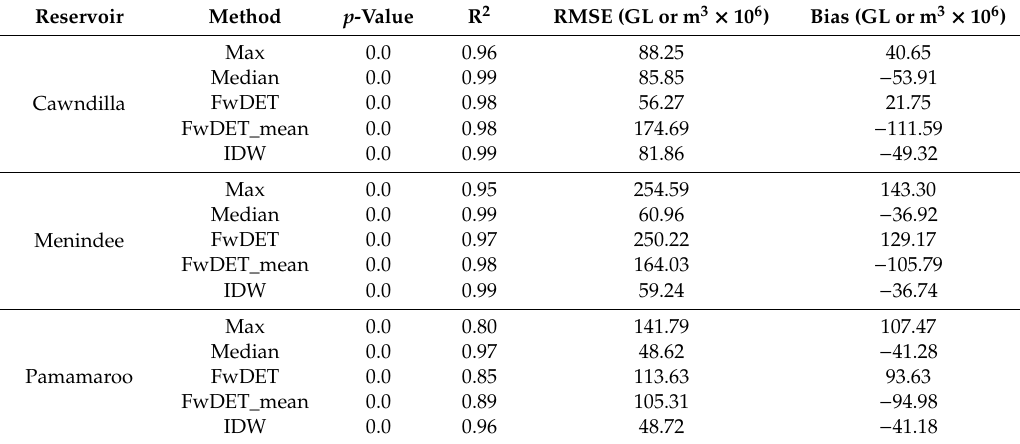
Table 2. Performance of the different methodologies used to estimate water volumes in the Menindee